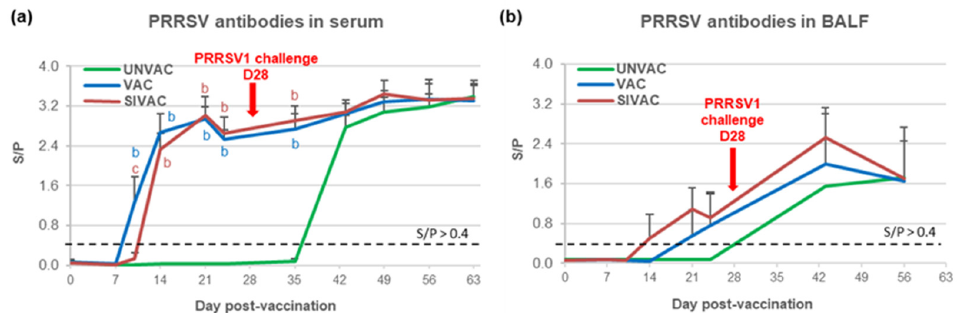
Figure 7. Anti-PRRSV antibody response assessed by ELISA in ( a ) serum or in ( b ) BALF. Data are reported as the mean (± SD) of results the obtained from all piglets in each group. Different letters (b,c) indicate that the considered group (specified by its color) was significantly different from the UNVAC group (b) or from the VAC group (c) with p < 0.05.